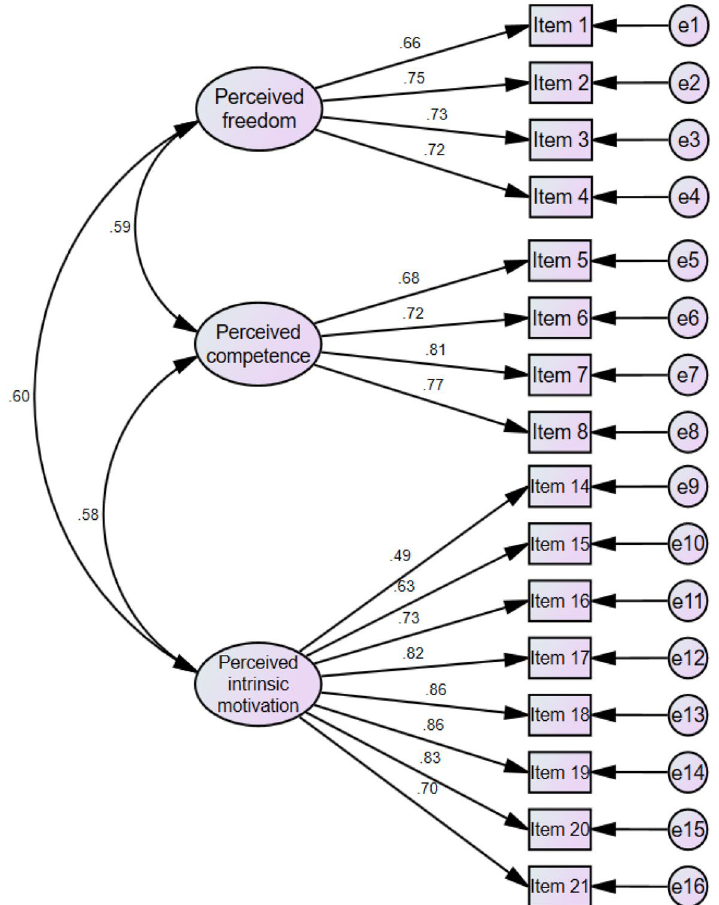
Figure 1. Factor loadings and factor intercorrelations for leisure